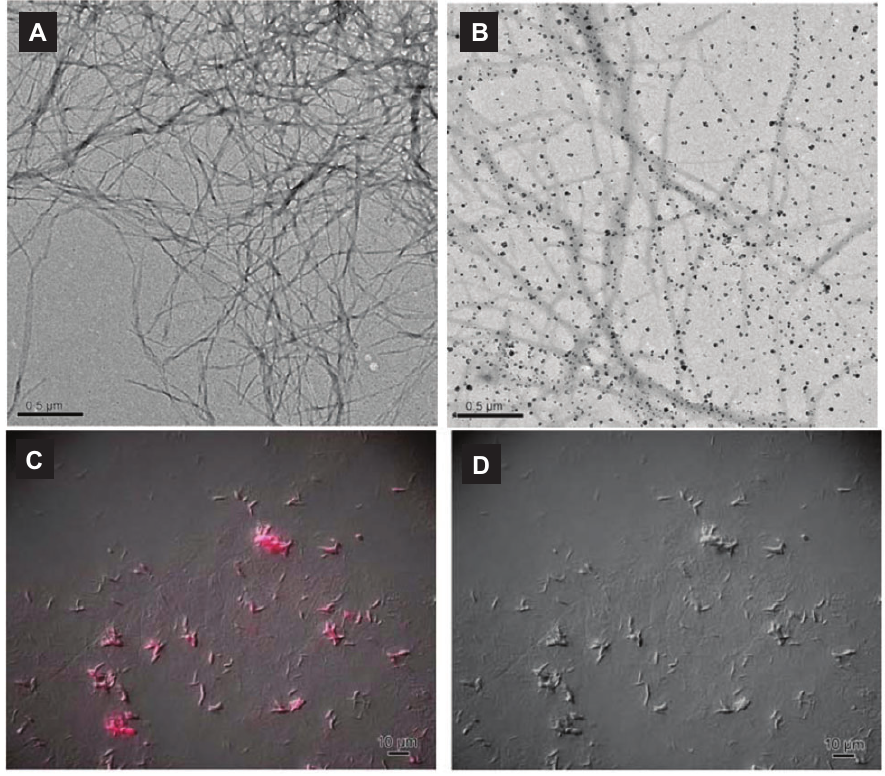
Figure 2 TEM and fluorescence microscopy images of amyloid-like fibrils labeled with fluorescent magnetic nanoparticles. (A) TEM image of amyloid β fibrils. (B) TEM image of amyloid β fibrils stained with magnetic nanoparticles. (C) Fluorescence microscope image of fibrils stained with multimodal nanoparticles. (D) Corresponding microscope image. Reproduced, with permission from Elsevier, from (46)